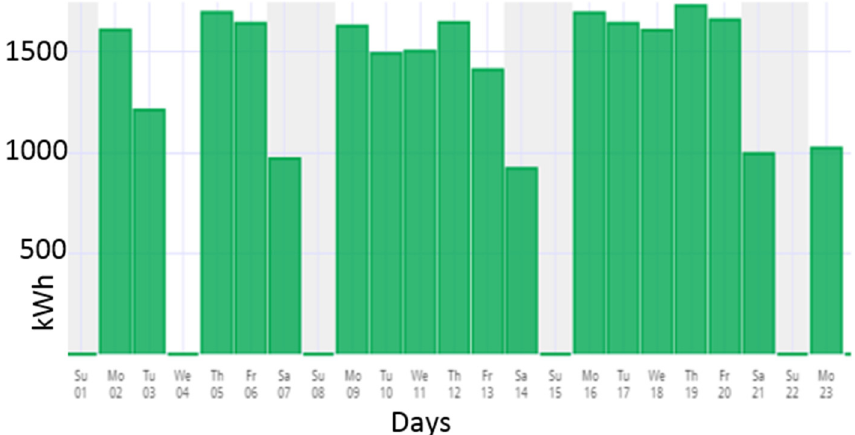
Figure 7. The thermal energy consumption pattern of PTC buildings, Aras An Phiarsaigh, December 2013 [42].